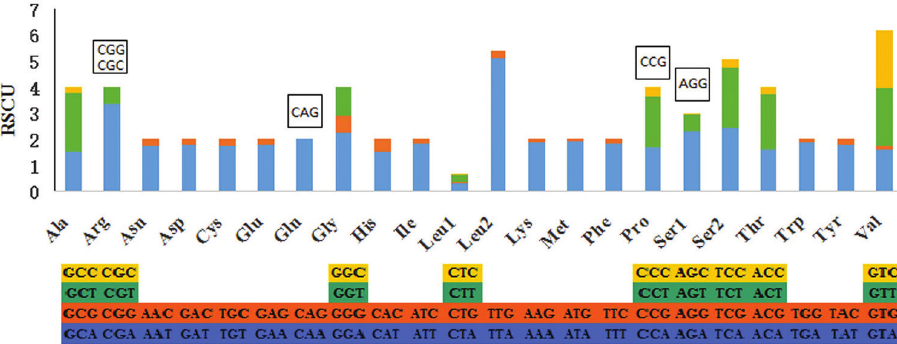
Figure 3. The relative synonymous codon usage (RSCU) in the mitogenome of T. japonica . The codons listed up the columns are absent in T. japonica